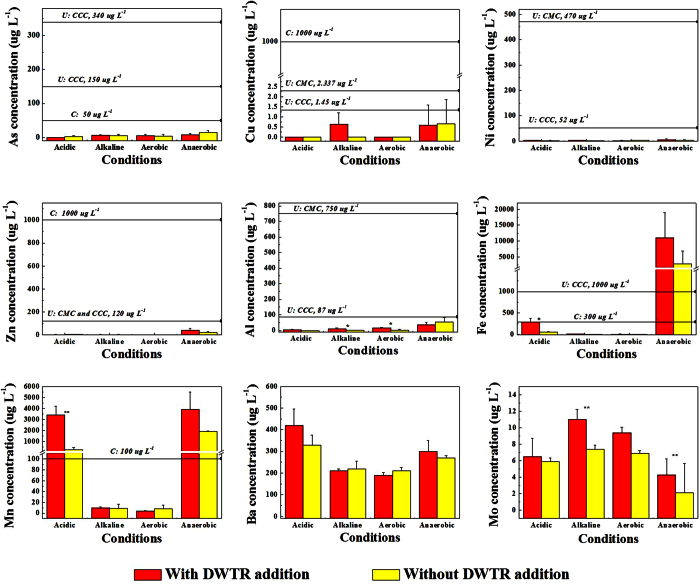
Effect of DWTR addition on the metals and As concentrations in lake water under different conditions.Mean values of concentrations measured at the 10th, 20th, and 30th d (n = 6) are presented. *And **represent significant differences at p < 0.05 and 0.01, respectively, for the metals and As concentrations in lake water with and without DWTR addition. CMC represents Criteria Maximum Concentration; CCC represents Criterion Continuous Concentration; U represents National Recommended Water Quality Criteria for freshwater in USA37; C represents Surface Water Quality Standard Class III used in China38; and Acute and chronic represent acute and chronic toxicity.